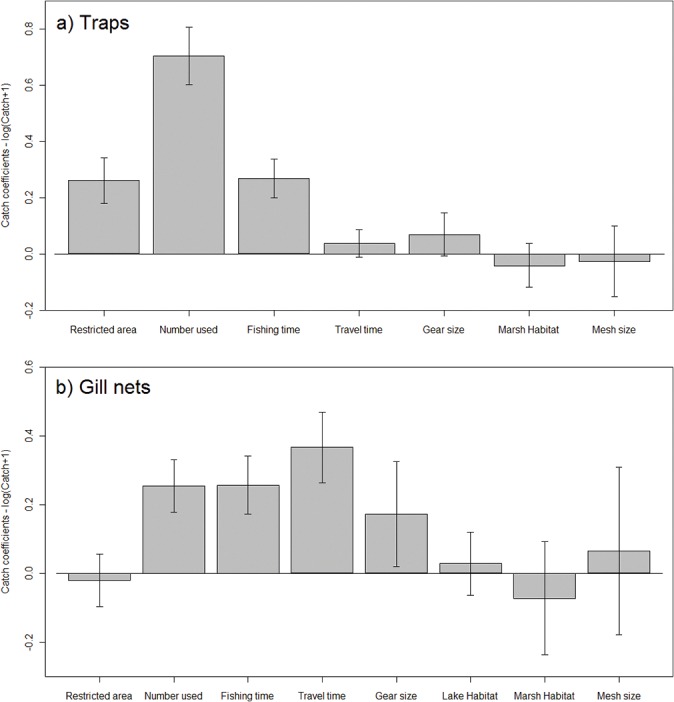
Factors affecting catch weight.Coefficient averages (± 1SE) from the candidate set of models for a) traps and b) gill nets, explaining the variation in catch weight as influenced by restricted area status (restricted versus non-restricted), fisher effort, habitat, and gear characteristics. Restricted area = fishing location is in an area with restricted status; Number used = number of gear items used; Fishing time = time spent fishing; Travel time = travel time to fishing location; Gear size = size of gear used; Lake Habitat = fishing location is in lake habitat; Marsh Habitat = fishing location is in marsh habitat; Mesh size = size of mesh of gear items used. Baseline (i.e., zero line) levels for restricted and habitat variables are ‘non-restricted’ and ‘edge habitat’, respectively. See S2 Table for variable descriptions and S5 Table for coefficient values or see http://dx.doi.org/10.6084/m9.figshare.1309446.